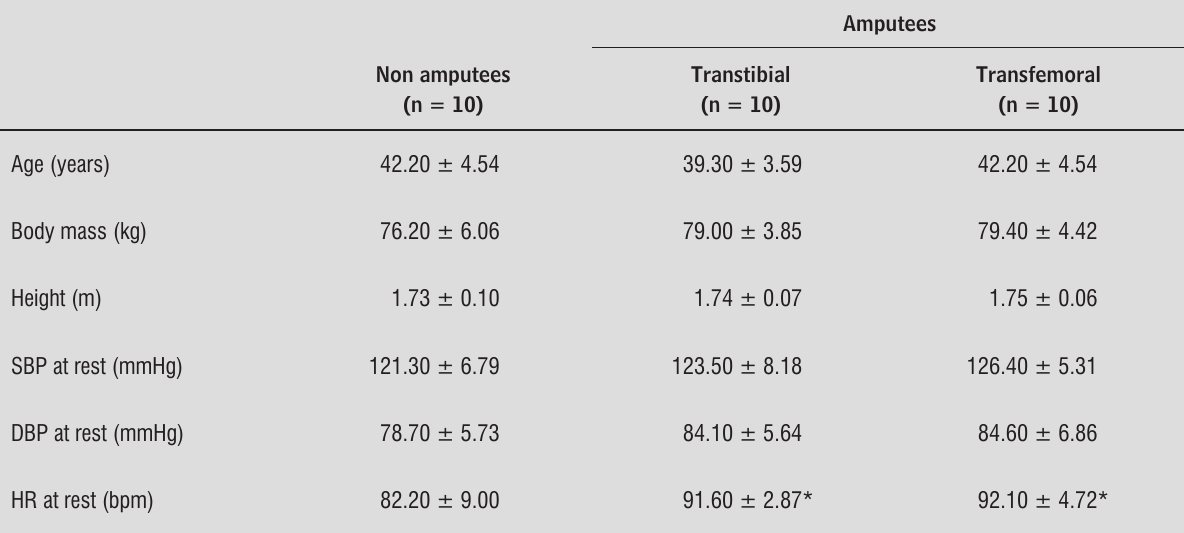
Table 1 - Characterization of the sample at rest (mean ± standard